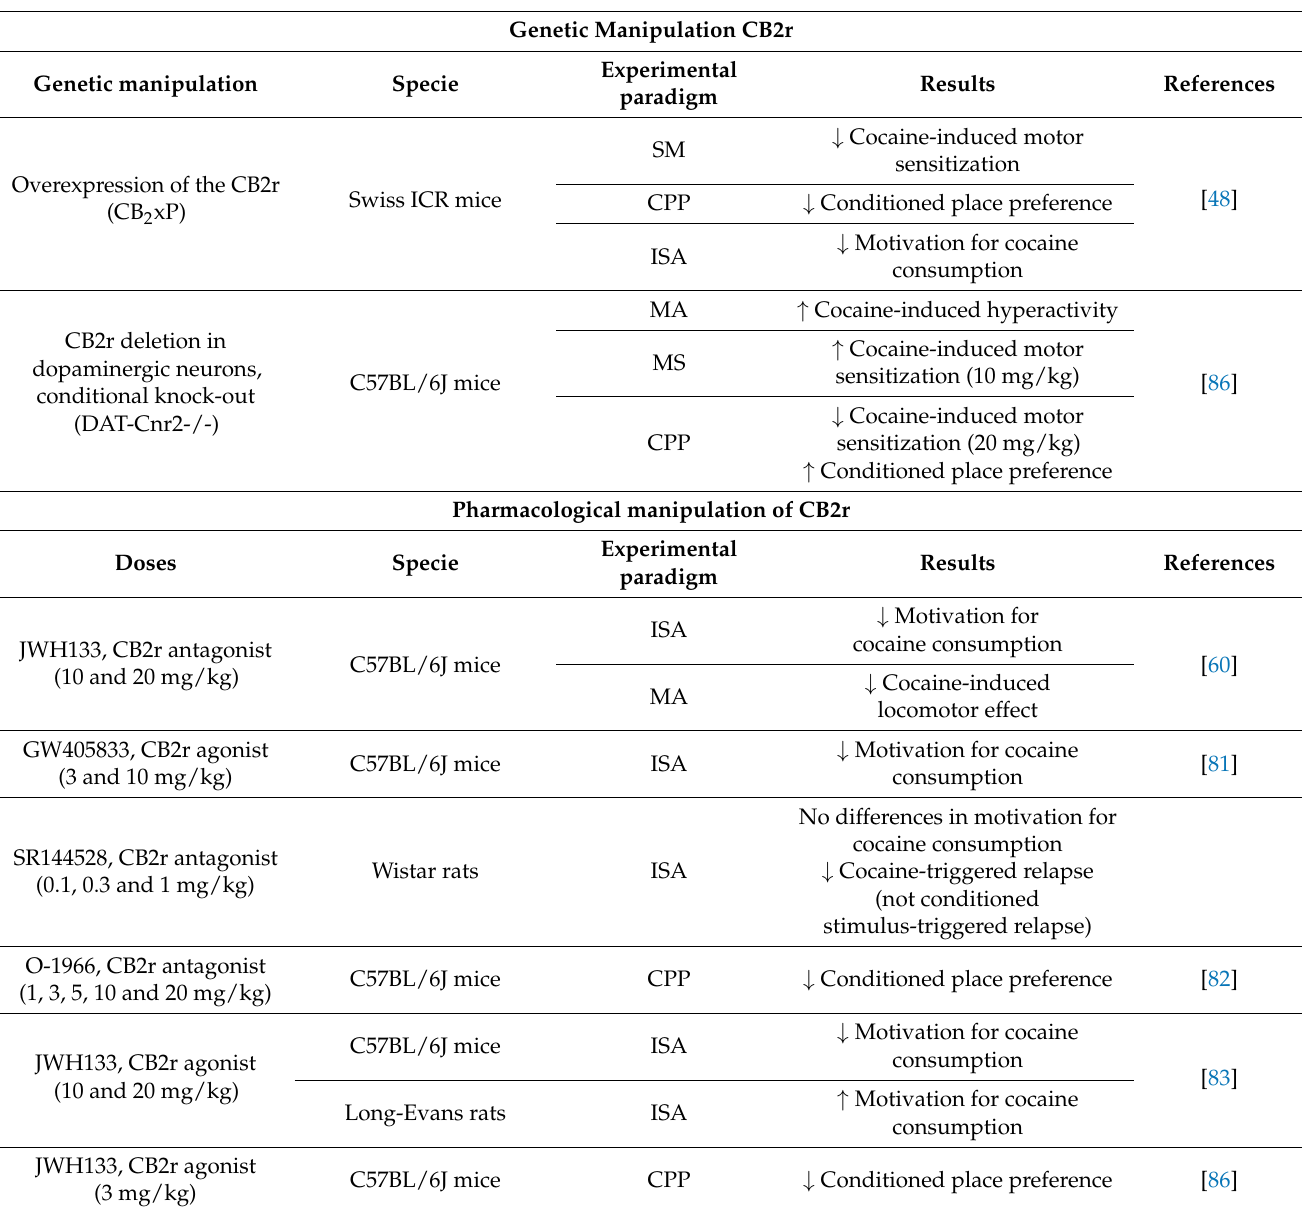
Table 2. Main findings supporting the involvement of CB2r in the regulation of the reinforcing and motivational effects of cocaine. CB2r & Cocaine-Animals Studies Genetic Manipulation CB2r Experimental Genetic manipulation Specie paradigm